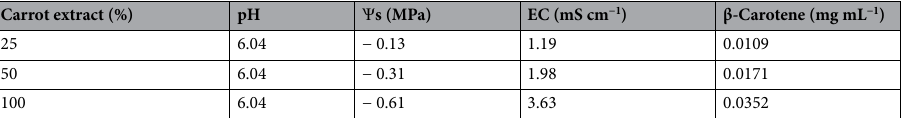
Table 1. Characterization of the carrot extract as pH, osmotic potential ( Ѱ s), electrical conductivity (EC), and β-Carotene